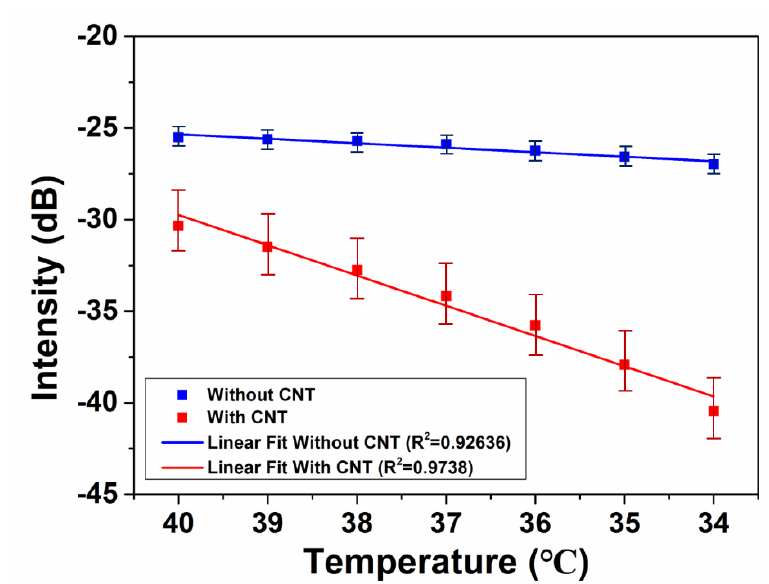
Figure 6. The relationship and linear fitting between temperature and interference dip intensity without (blue line) and with (red line) CNT coating.